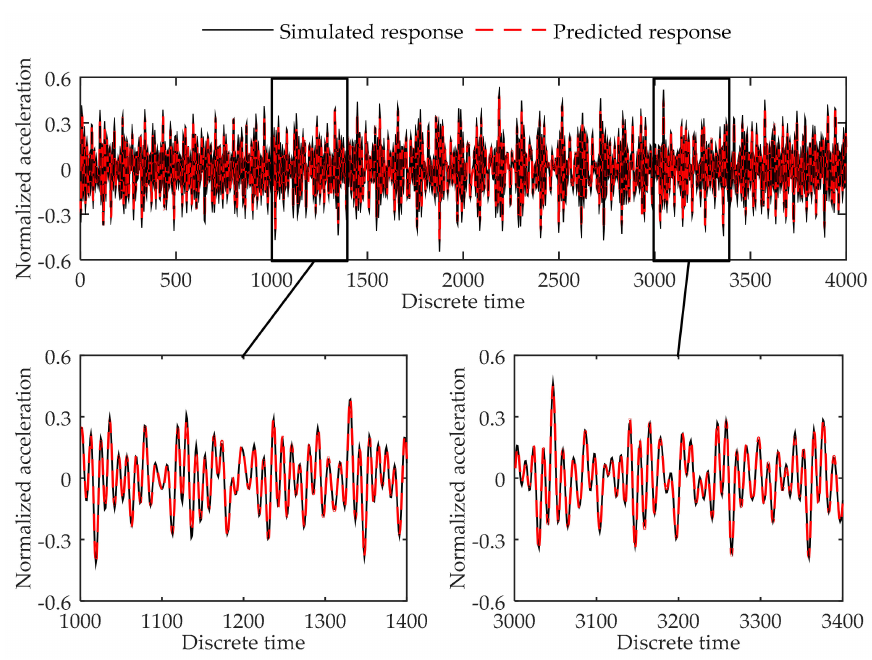
Figure 8. Comparison between the predicted response and true responses of node 352 at the cantilever plate finite element model in validation dataset.